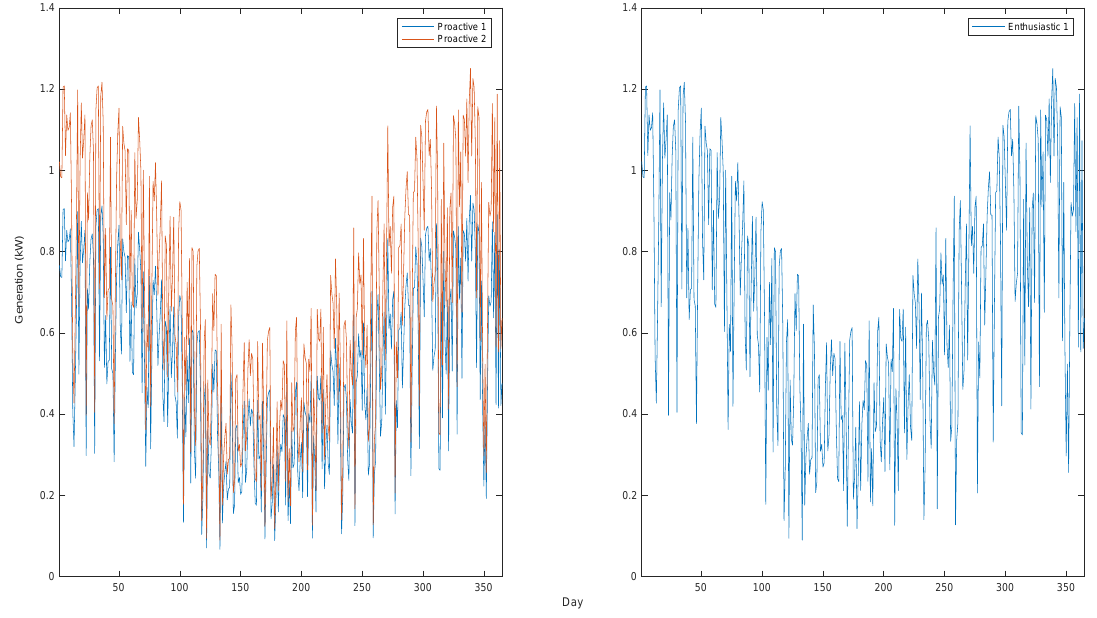
Figure 9. Yearly generation profiles of different houses in the